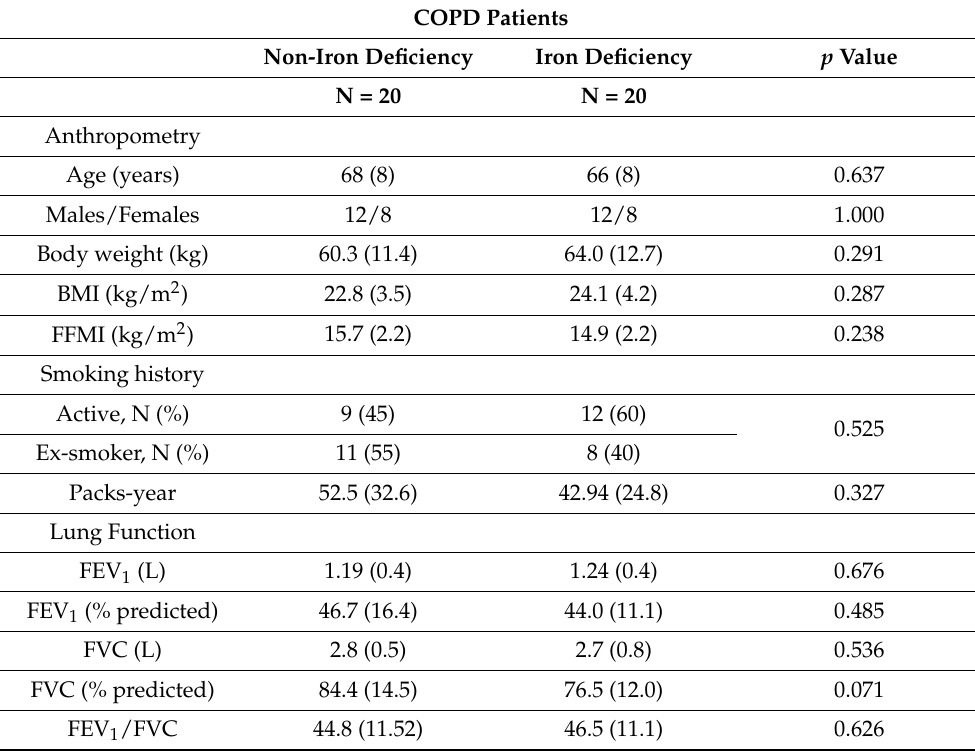
Table 1. General clinical characteristics of the study